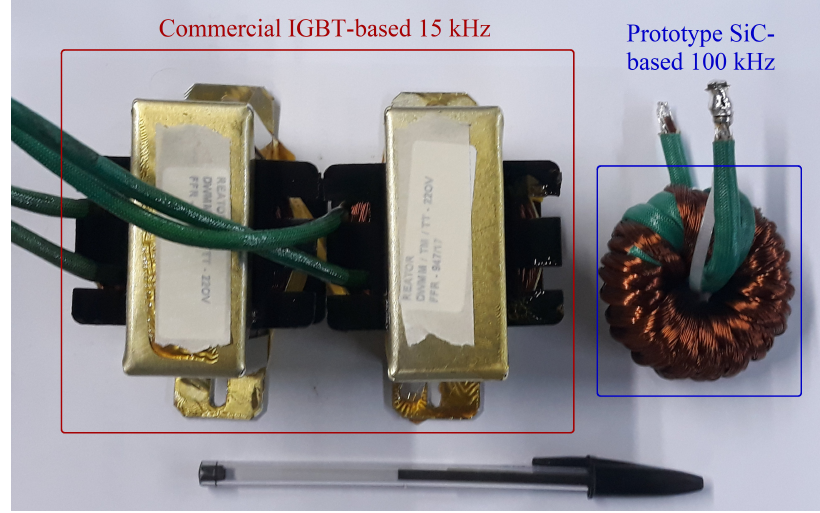
Figure 11. Size comparison between filter inductors for the developed SiC-based prototype and for a commercial IGBT-based UPS with the same